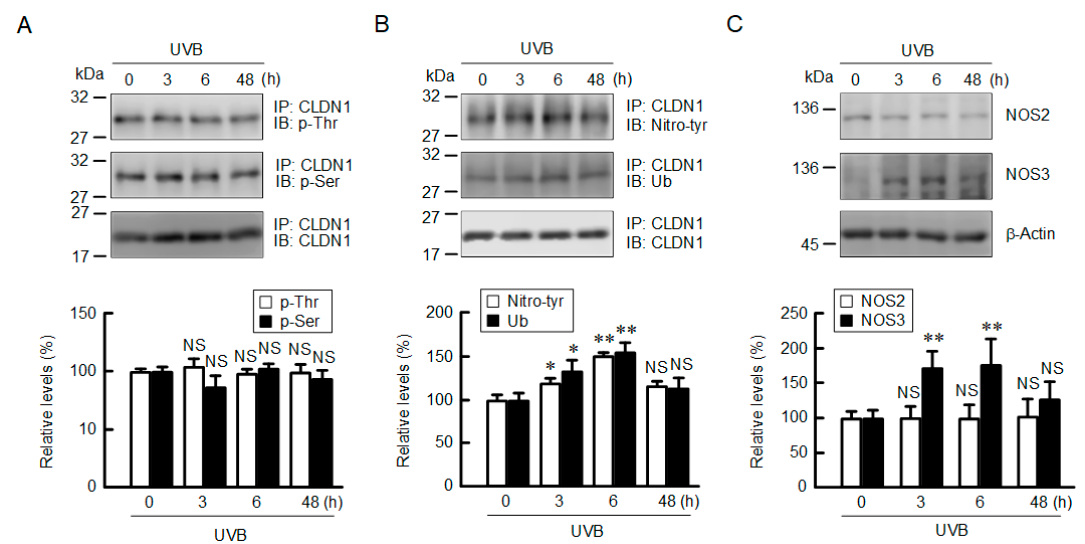
Figure 4. Effect of weak UVB irradiation on phosphorylation, ubiquitination, and tyrosine nitration of CLDN1. After exposing to weak UVB, the cells were cultured for the period indicated. ( A , B ) After we performed immunoprecipitation with anti-CLDN1 antibodies, the immunoprecipitants were applied to SDS-PAGE and blotted with anti-phosphothreonine (p-Thr), anti-phosphoserine (p-Ser), anti-tyrosine nitration (Nitro-tyr), anti-ubiquitin (Ub), and anti-CLDN1 antibodies. The full-length blot images are shown in Figures S3–S5. The levels of p-Thr, p-Ser, Nitro-tyr, and Ub of CLDN1 are represented as a percentage of 0 h. n = 3. ( C ) Cell lysates were applied to SDS-PAGE followed by blotting with anti-NO synthase 2 (NOS2), anti-NOS3, and anti- β -actin antibodies. The levels of NOS2 and NOS3 are represented as a percentage of 0 h. n = 4. ** p < 0.01, * p < 0.05, and NS p > 0.05 vs. 0 h.